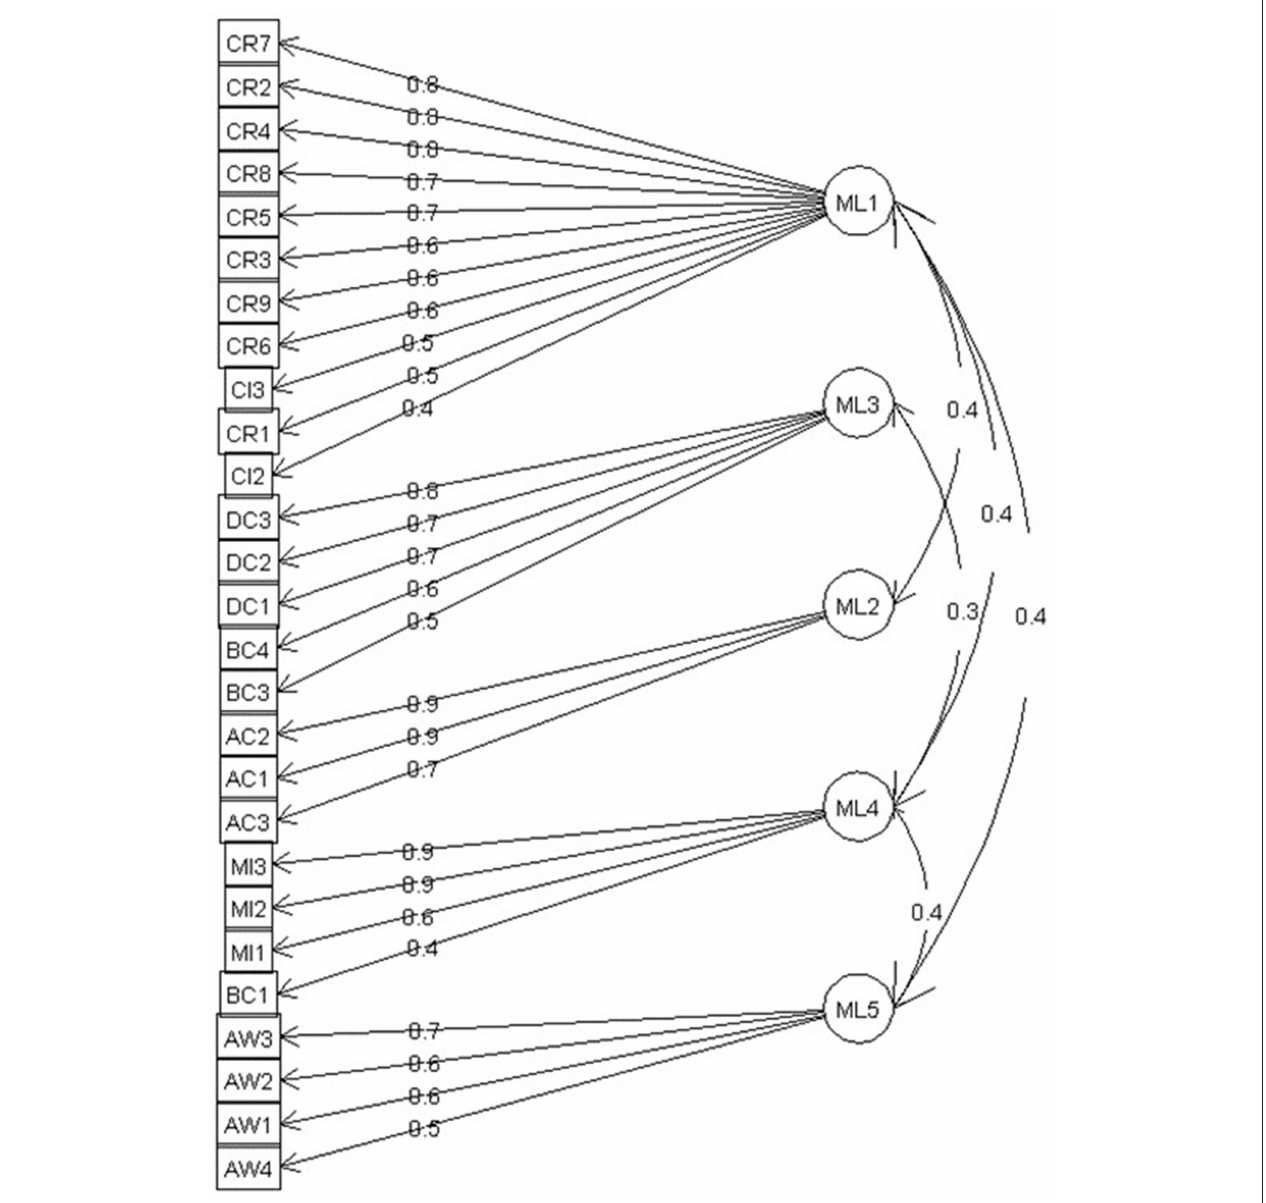
FIGURE 1 | Factor model of FLS with standardized factor loadings represented on unidirectional arrows. Factors in this figure are represented by the following key. ML1, Credible Source Challenge; ML2, Feedback Acceptance; ML3, Behavioral Changes and Developmental Actions; ML4, Motivational Intentions; and ML5, Awareness from Feedback. See Appendix for a detailed key to